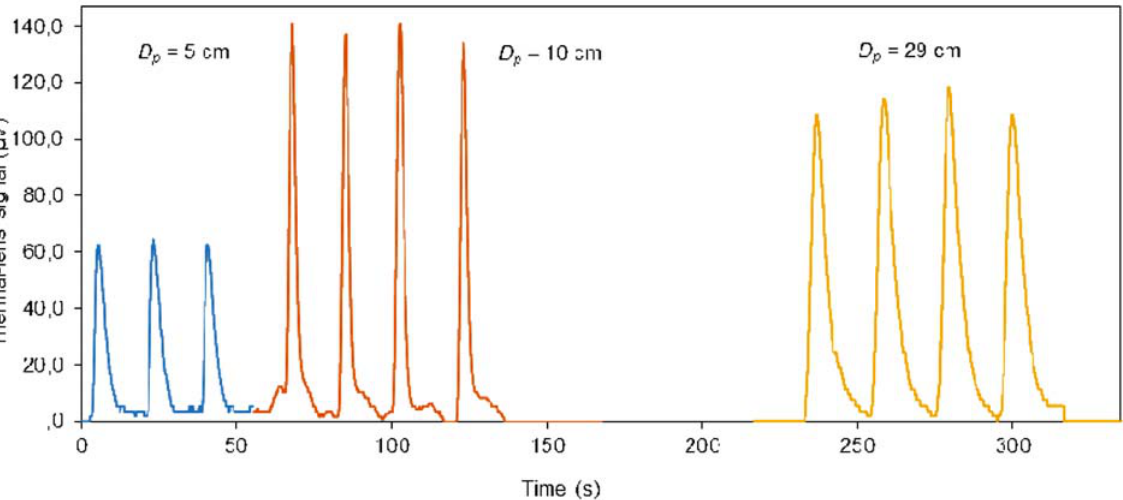
Figure 5. Shapes of the thermal-lens signal of Cr(VI) (4 μmol L –1 ) complex with diphenylcarbazide (20 μmol L –1 ) for various positions of the de- tector from the mixing point; flow rate, 10 μL min –1 , injection volume of the reagent, 0.9 μL; excitation power, 100 mW.